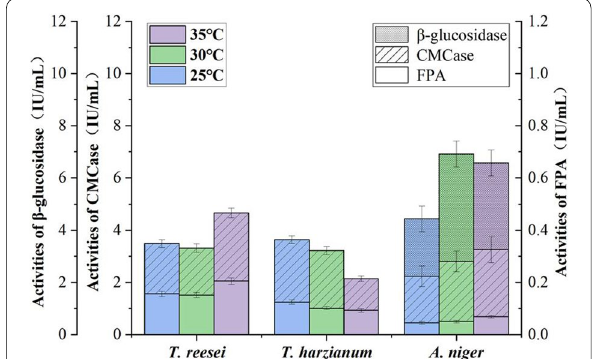
Fig. 2 Effects of temperature on the production of cellulases by